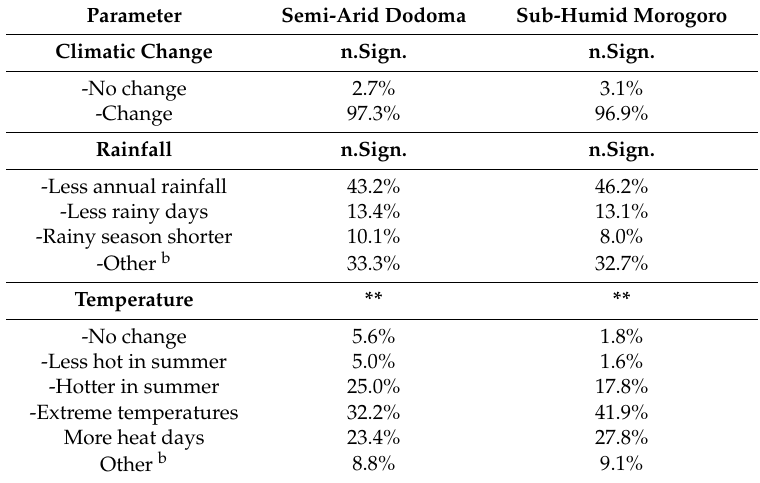
Table 1. Perceptions of climatic change in Dodoma and Morogoro (Mann–Whitney-U Test). Parameter Semi-Arid Dodoma Climatic Change